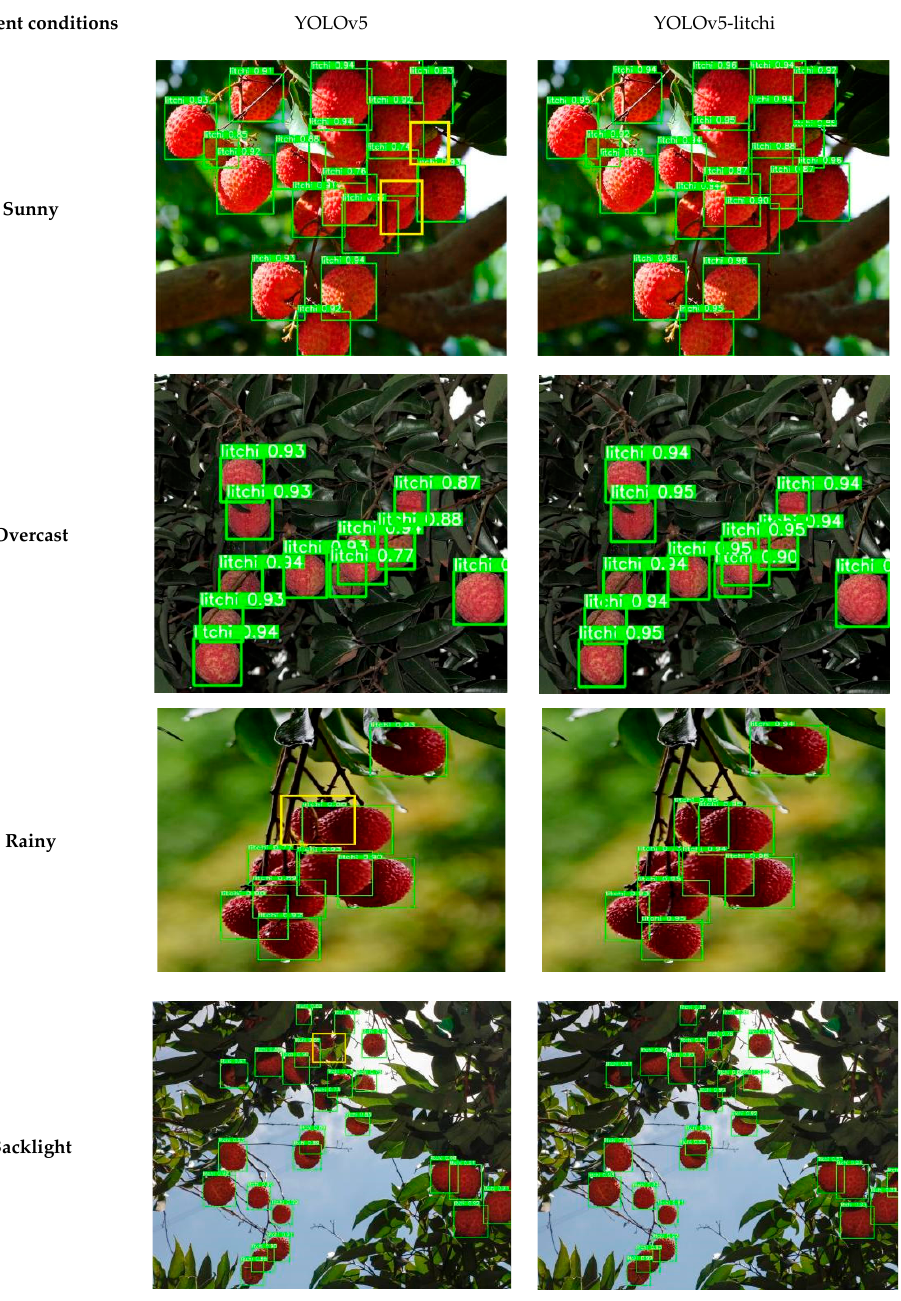
Figure 11. A comparison of litchi detection under different weather conditions before and after im- provement.